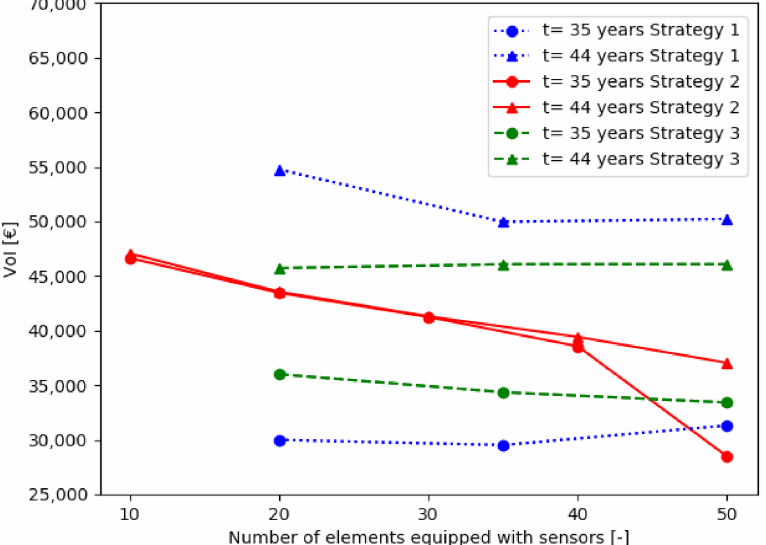
Figure 7. Influence of the number of elements equipped with sensors on the VoI (for the strategies, reference is made to Table